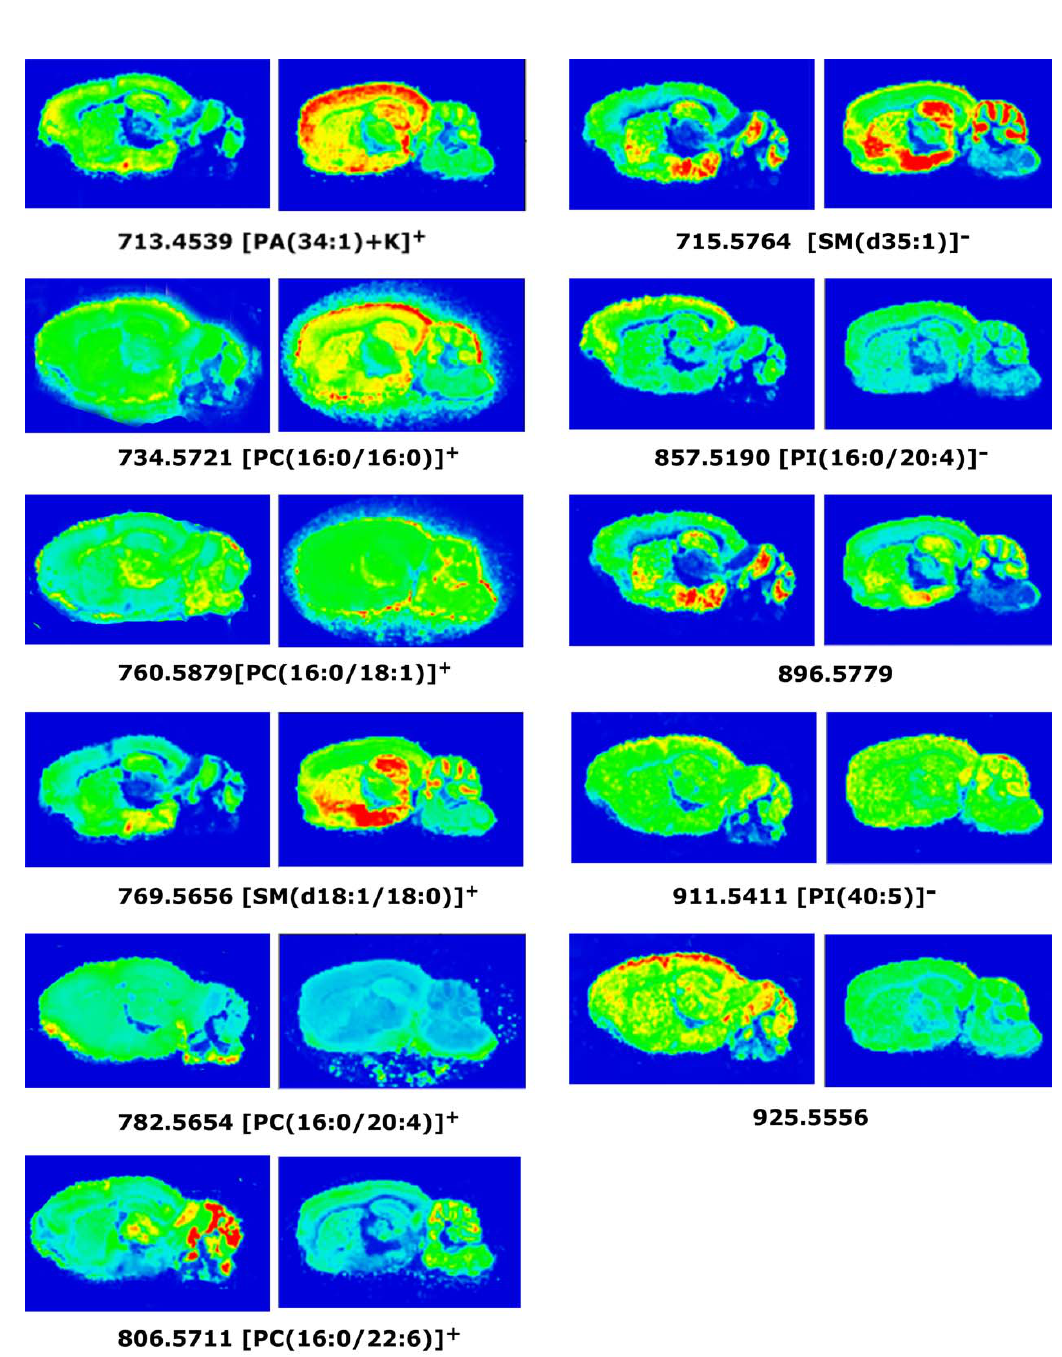
Figure 6. MALDI-MSI images representing different lipid species showing changes in the detection intensities between WT ( left images) and 3xTg-AD ( right ) mice in sagittal CNS sections.